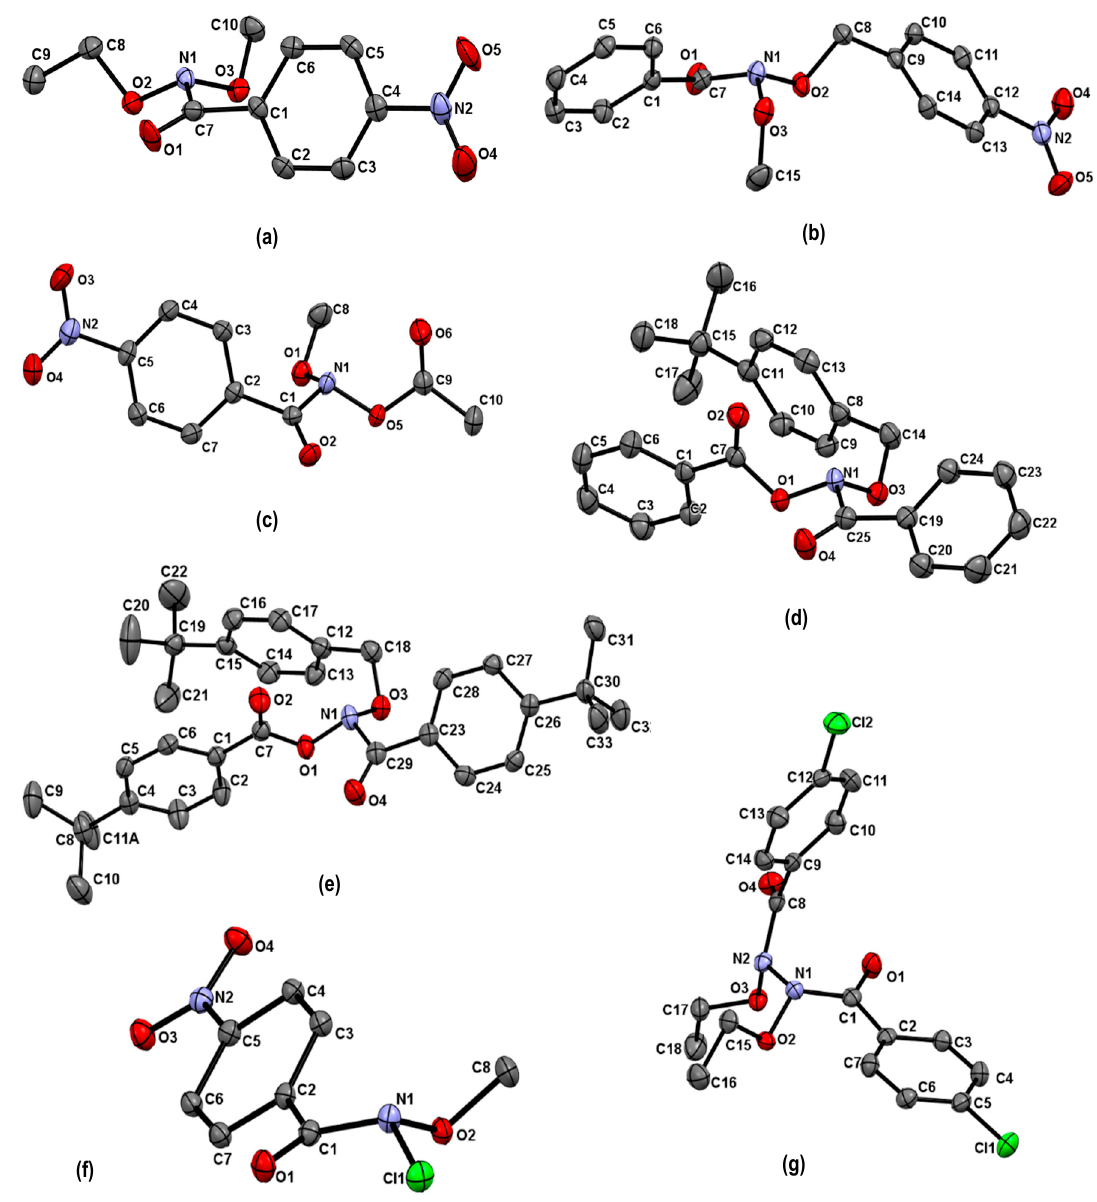
Figure 6. X-ray structures for ( a ) N -ethoxy- N -methoxy-4-nitrobenzamide 5a [33], ( b ) N -methoxy- N -(4-nitrobenzyloxy)benzamide 5b [33], ( c ) N -acetoxy- N -methoxy-4-nitrobenzamide 7 [65], ( d ) N -benzoyloxy- N -(4- tert -butylbenzyloxy)benzamide 6b [29], ( e ) N -(4- tert -butylbenzoyloxy)- N -(4- tert -butylbenzyloxy)-4- tert -butylbenzamide 6a [29], ( f ) N- chloro- N -methoxy-4-nitrobenzamide 9 [65], and ( g ) N , N ′ -4-chlorobenzoyl- N , N ′ -diethoxyhydrazine 8 [32].